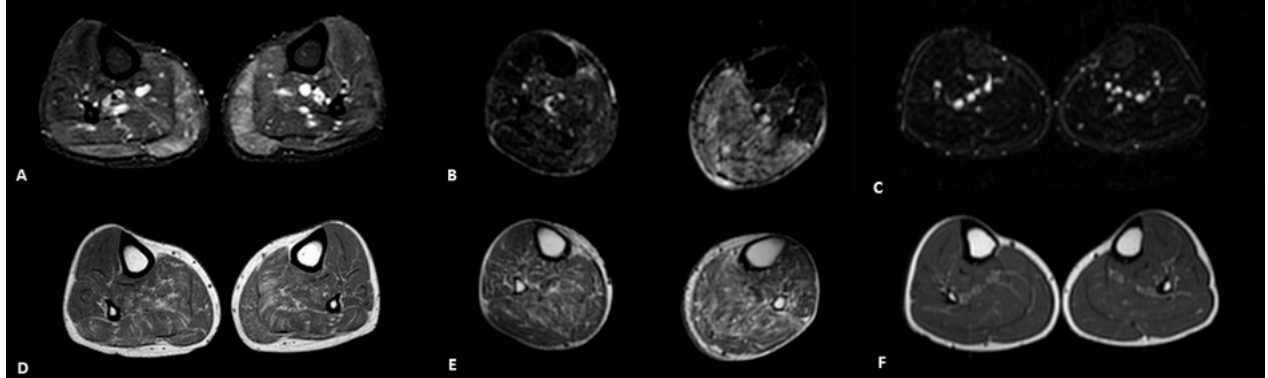
Figure 3. Muscle disease activity in ATTRv patients (#3 in ( A , D ); #6 in ( B , E )) and a control subject ( C , F ). STIR hyperintensities in gastrocnemii muscles without fatty degeneration as a sign of early involvement ( A , D ); STIR hyperintensities in posterior compartment of the leg with a severe muscle involvement ( B , E ); no STIR abnormalities in the control subject ( C , F ).